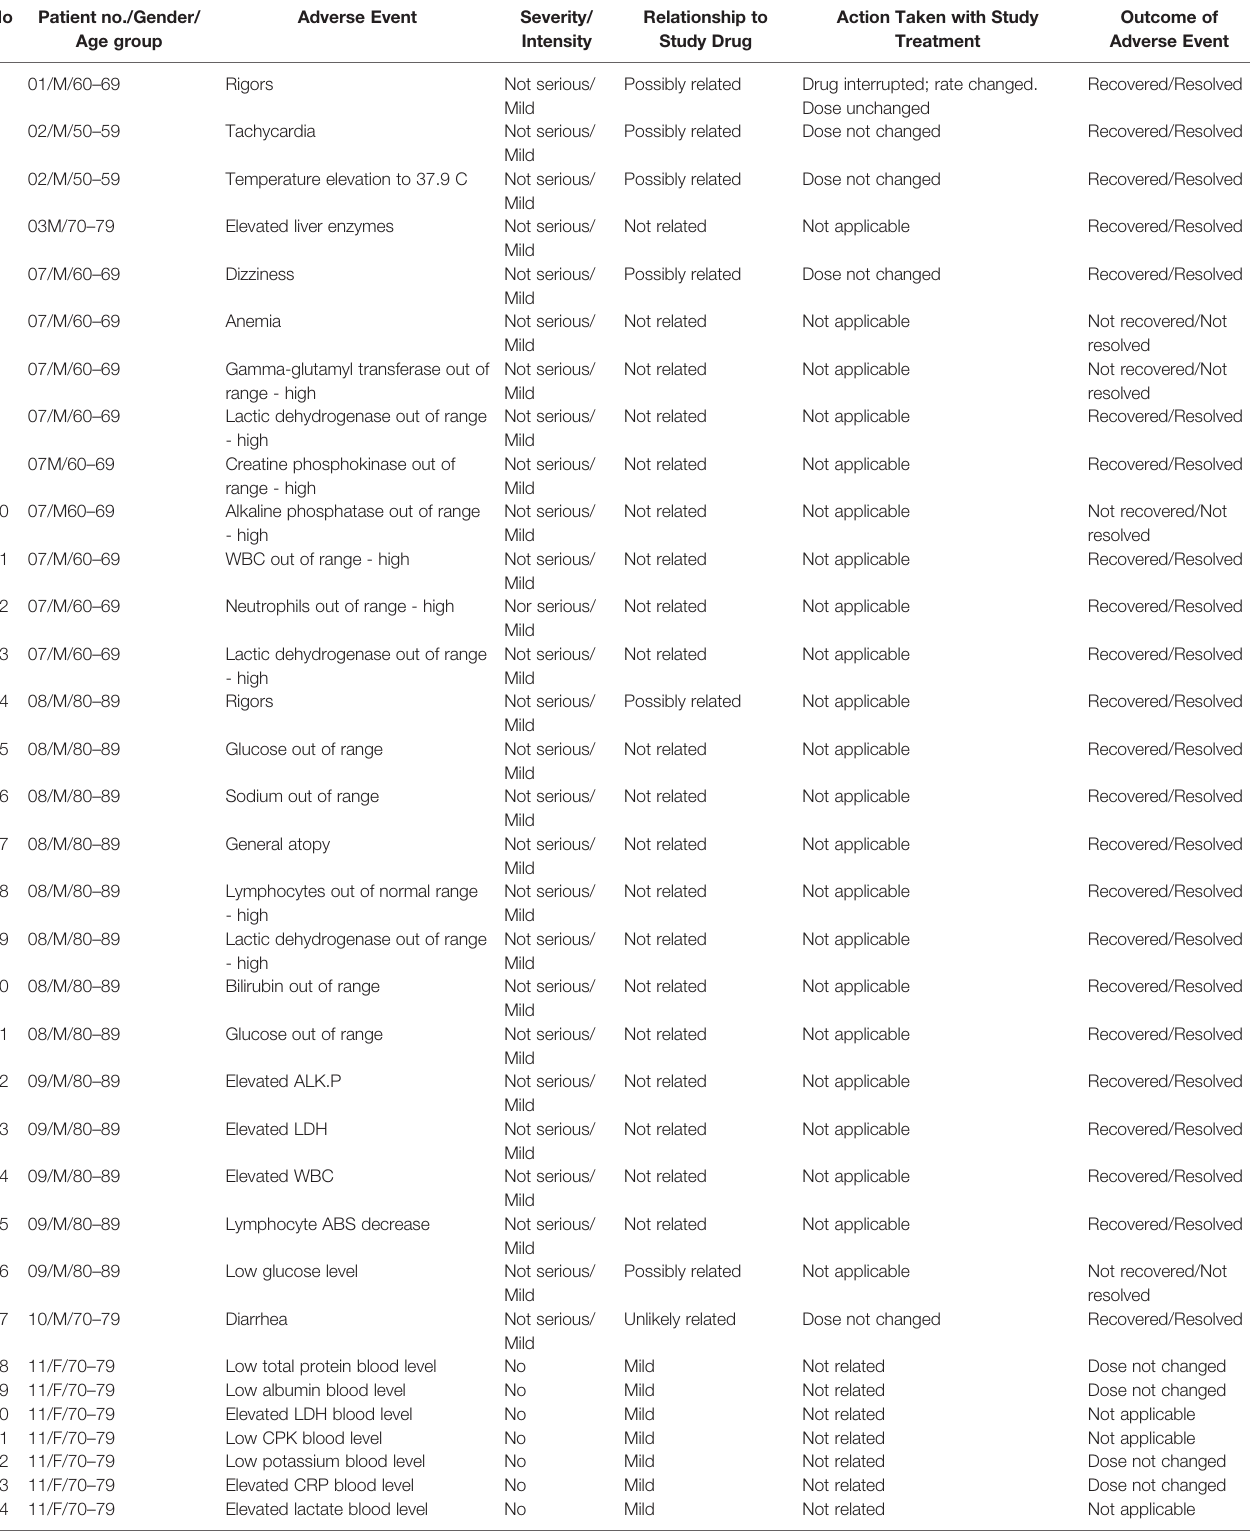
TABLE 2 | Complete list of adverse